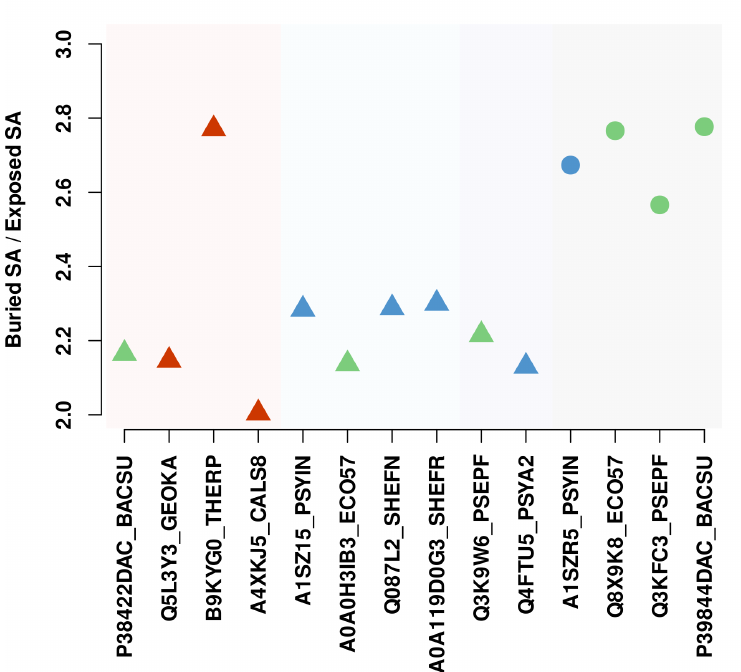
Figure 7. Ratio of external to internal surface area as a relative measure of packing for 100 ns simulations, arranged by sequence similarity. Trajectory means were determined using parametric bootstrap confidence intervals for accounting for autocorrelation over 5000 frames; 95% confidence intervals are smaller than plotted points and hence not visible. The results are consistent with those of Figure